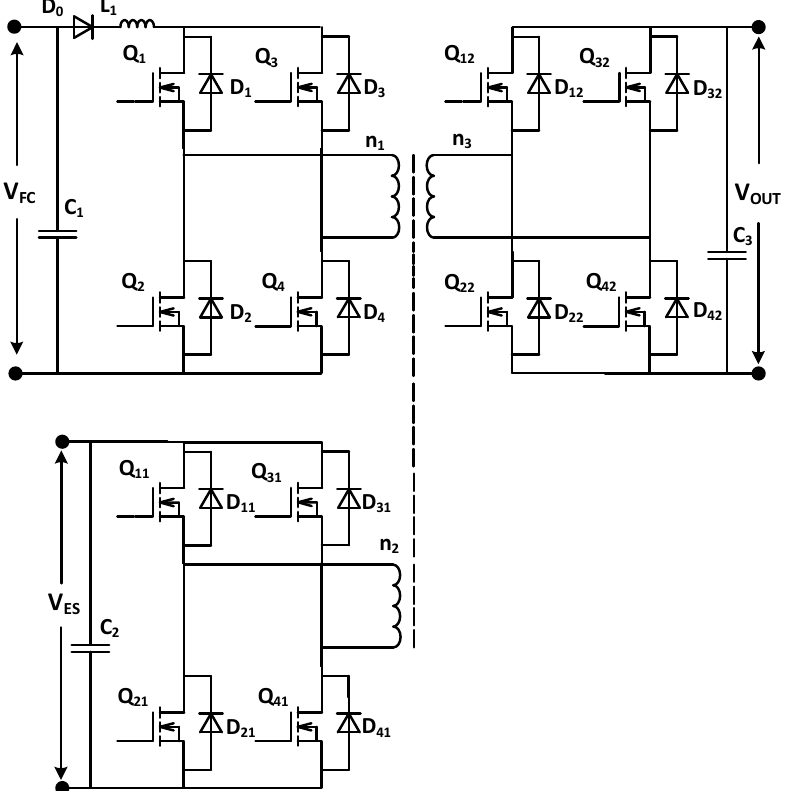
Figure 9. Topology of three port fully isolated multiport converter.